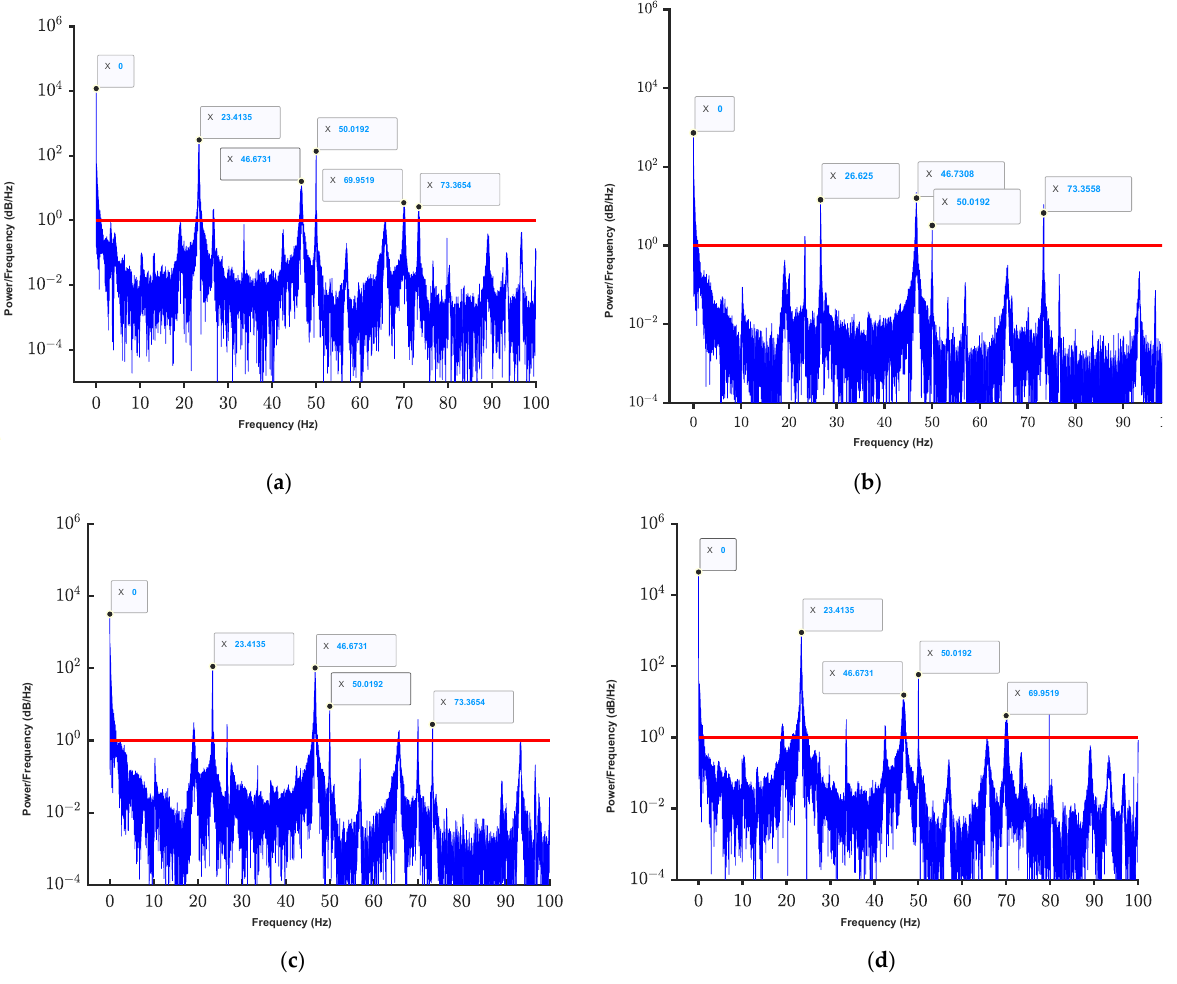
Figure 9. Power Spectral Density (PSD) of four response signals from four strain rosettes. ( a ) Response Signal-1; ( b ) Response Signal-2; ( c ) Response Signal-3; and ( d ) Response Signal-4. The red line in each represented the standard amplitude of the PSD.